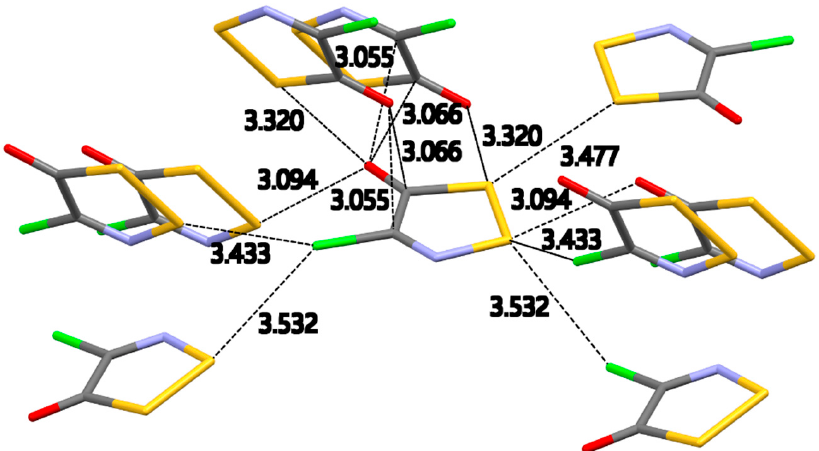
Figure 1. Intermolecular short contacts (Å) expanded for the central dithiazolone 2b in the asymmetric unit cell.